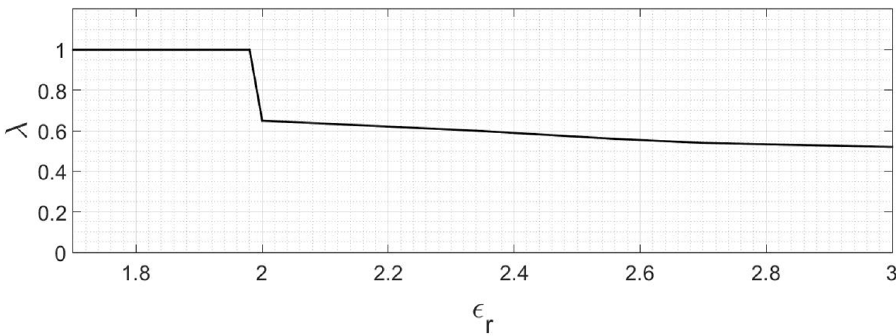
Fig. 18. Variation of l (at point S c ), as a function of e r for the 25/25 Nylon 6 gear pair.